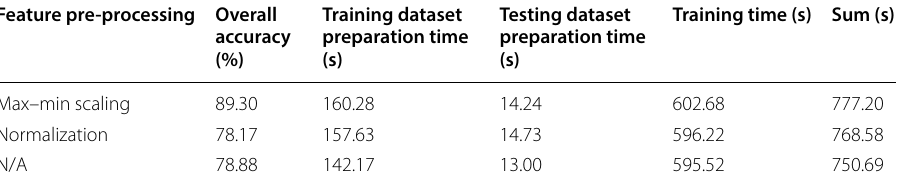
Table 6 Accuracy and efficiency analysis on feature pre-processing procedures